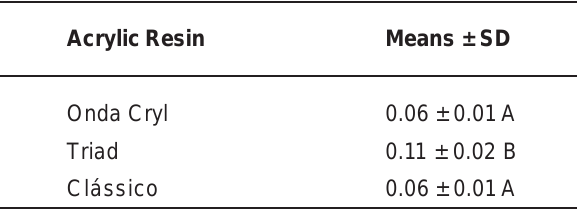
Mean followed by different letters are statistically different (p<0.05).